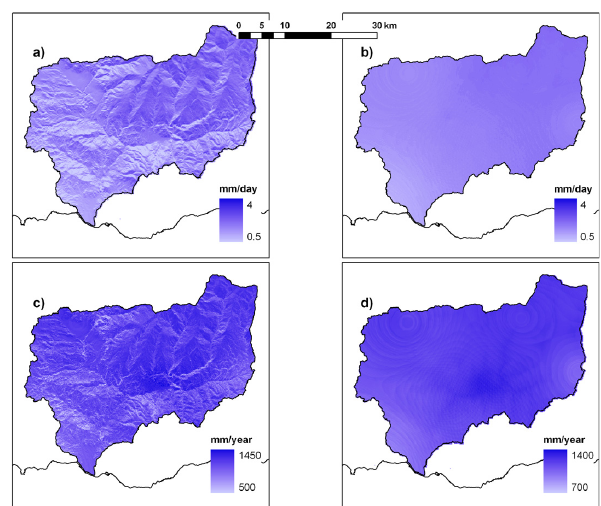
Fig. 8. Daily ET 0 with global radiation (20 November 2004) (a) to- pographically corrected vs. (b) IDW interpolated, and annual ET 0 with global radiation (1 September 2004–31 August 2005) (c) topo- graphically corrected vs. (d) IDW